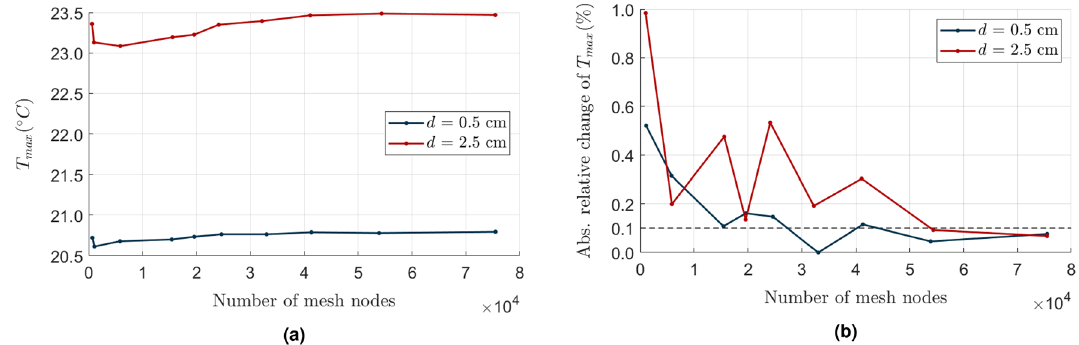
Figure 2. Maximum temperature of the model surface T max vs. the number of nodes in the mesh independence study. ( a ) shows the absolute relative changes of T max from ( b ) in subsequent mesh sizes. The dashed line shows the 0.1% level in ( a ).